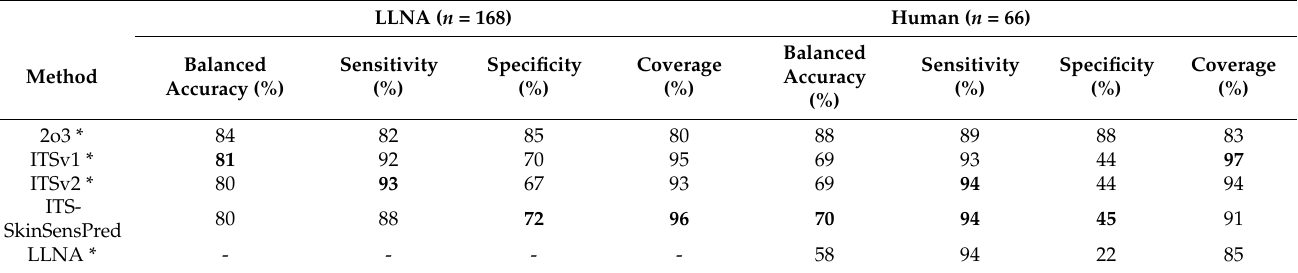
Table 1. Performance of hazard identification for LLNA data and human data.